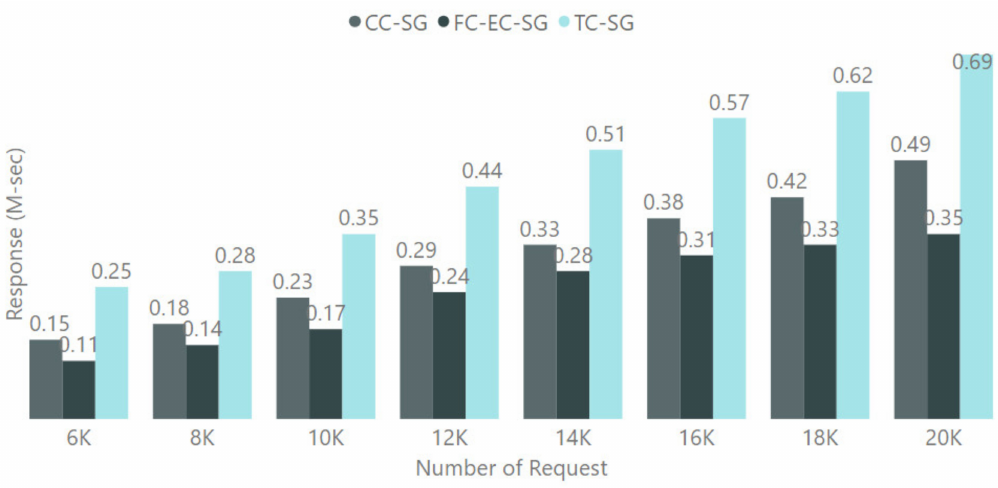
Figure 10. Time to response in CC-SG, FC-EC-SG, and